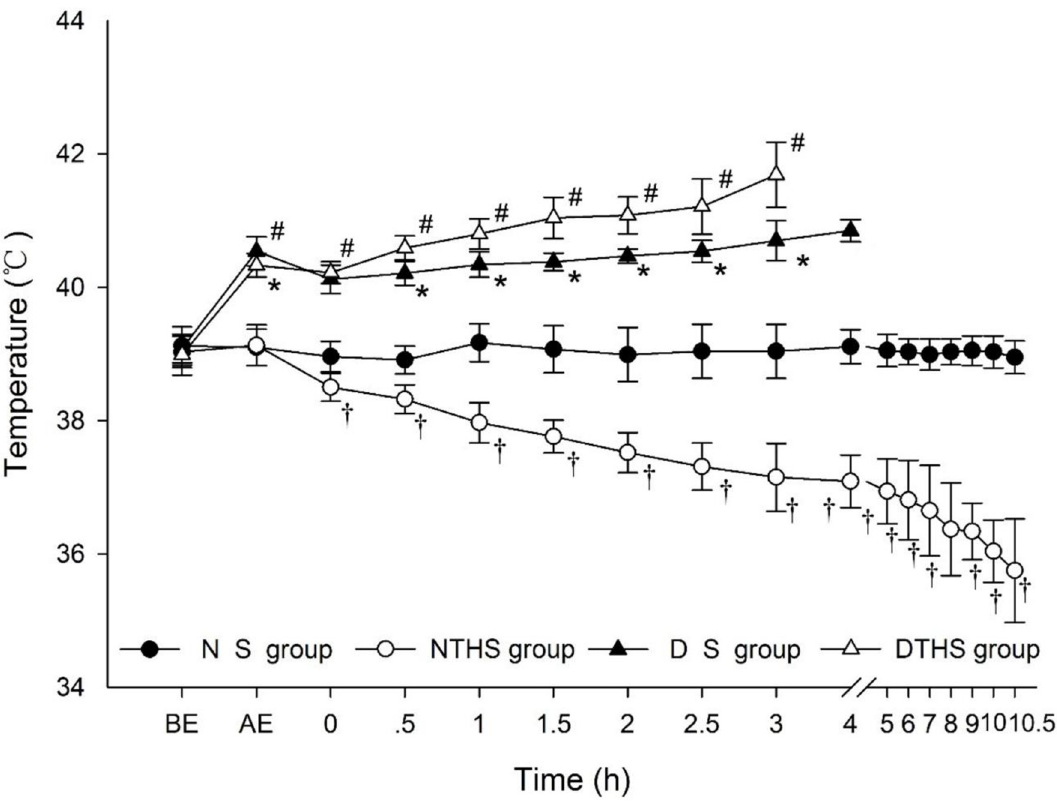
Fig 3. Temperature variation curve of desert dry-heat environment in traumatic hemorrhagic shock pigs. BE, before exposure; AE, after exposure. Values are shown as mean ± SEM. P < 0.05 was considered statistically significant. † P, # P, and � P denote statistically significant difference for NS vs. NTHS, DTHS vs. NTHS, and DTHS vs. DS, respectively.